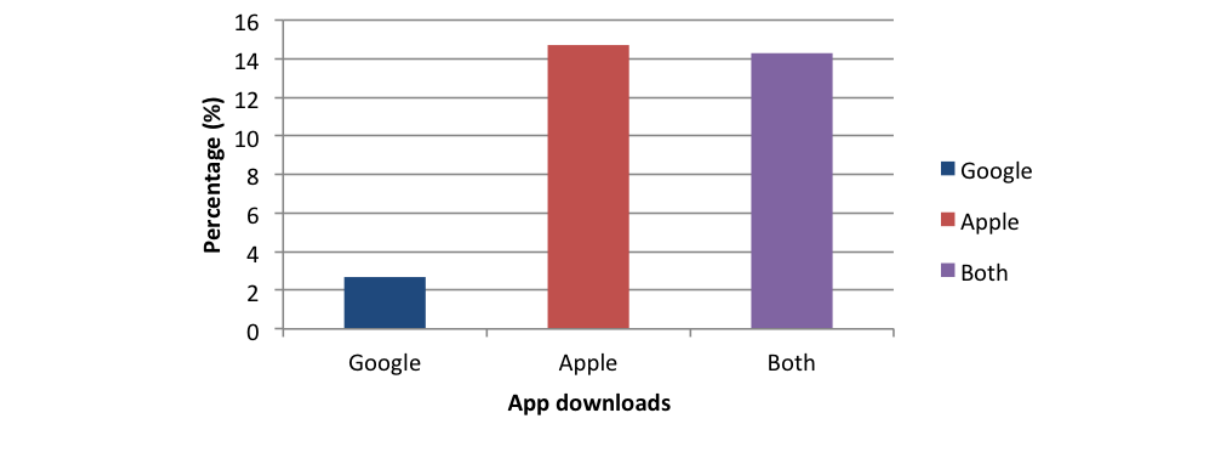
Figure 8. Chart comparing educational method percentage among apps in different app stores.